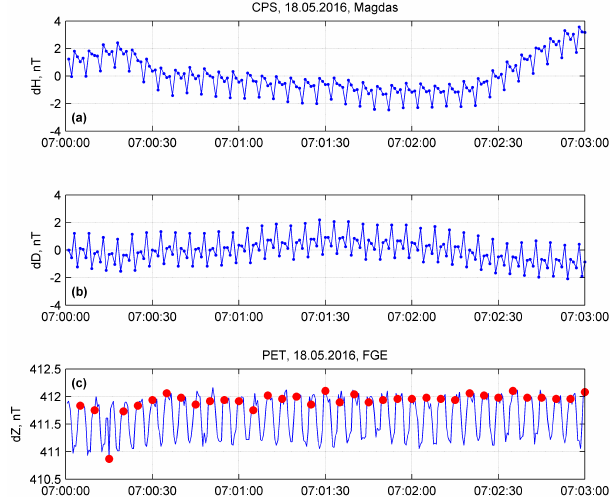
Figure 3. An example of influence of the magnetometers with Over- hauser scalar sensors: (a, b) effect of vector dIdD GSM-19FD in the records of H and D components of MAGDAS fluxgate variometer at the Cape Schmidt observatory, (c) influence of the scalar magne- tometer GSM-90 on the vertical component Z of the FGE fluxgate variometer at the Paratunka observatory. Oscillations of d Z have the period of GSM-90 measurements, undisturbed d Z are found at up- per part of oscillations; red dots show undisturbed values, which are used for the next processing